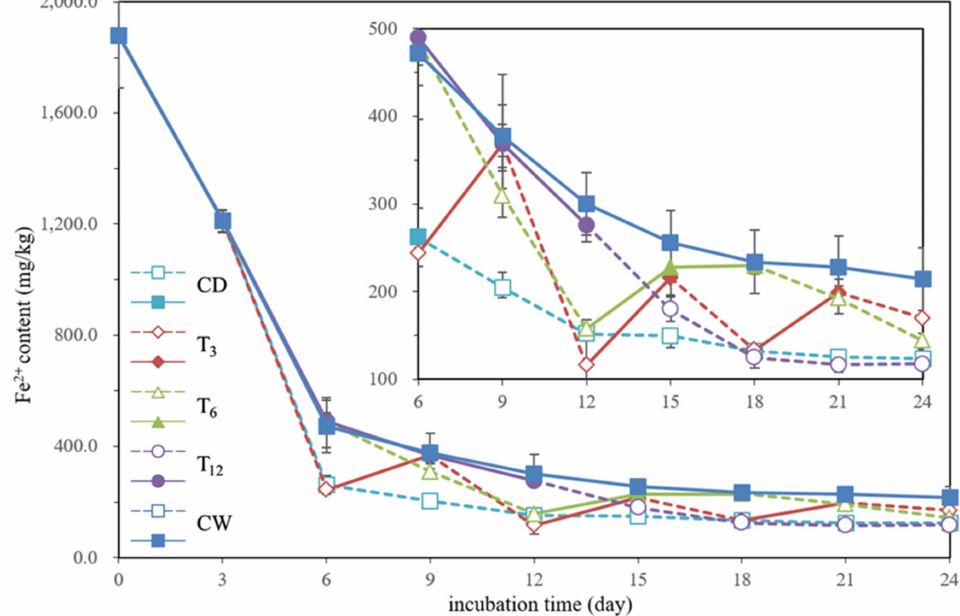
Figure 5. The dynamic of Fe 2+ content in different treatments. The solid and dotted lines represent the rewetting and drying period, respectively. The vertical bars refer to one standard deviation ( n = 3).